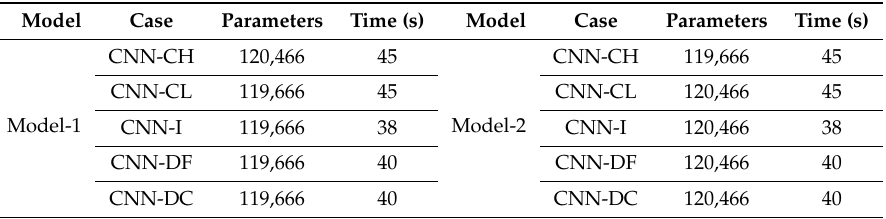
Table 7. Required time and number of